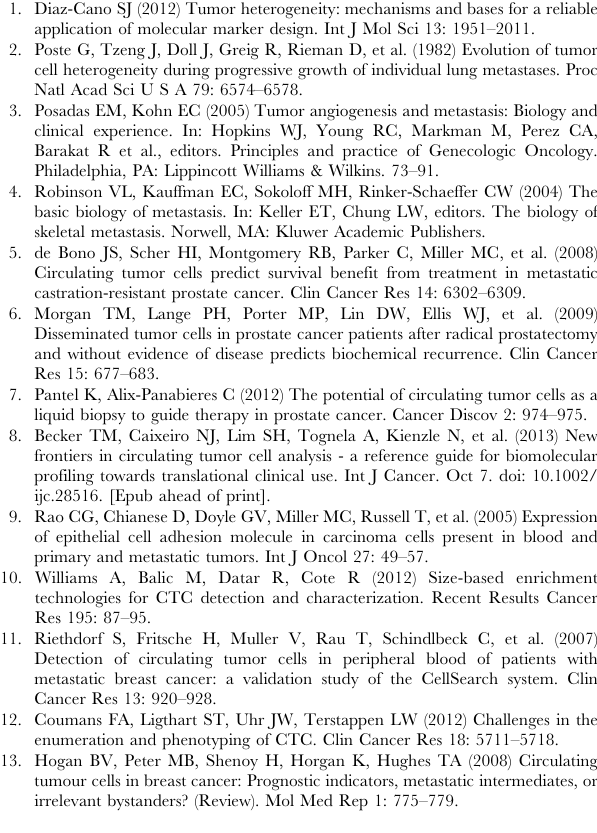
Figure S3 Lack of statistical significance between CTC counts and common diagnostic parameters. Counts of the candidate CTCs from 40 primary prostate cancer patients and 23 samples from 5 mCRPC cases were analyzed against surgical margin, Gleason score, T-stage and N-stage of the patient. Table S1 Detection of PC-3 cells spiked to donor blood.